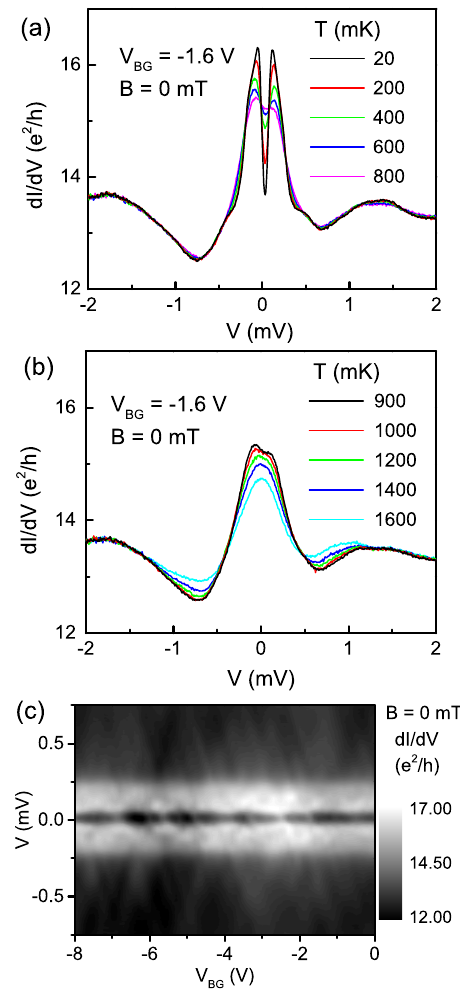
FIG. 2. (a) Conductance versus source-drain bias V for various temperatures at zero field. At low bias, the conductance is suppressed due to the reentrant resistance effect. (b) Conductance traces at zero field and elevated temperature. When the temper- ature exceeds the Thouless energy, the low-bias conductance suppression is replaced by a broad conductance peak. (c) Color plot of dI=dV versus source-drain bias V and backgate bias V at zero field and 20 mK.